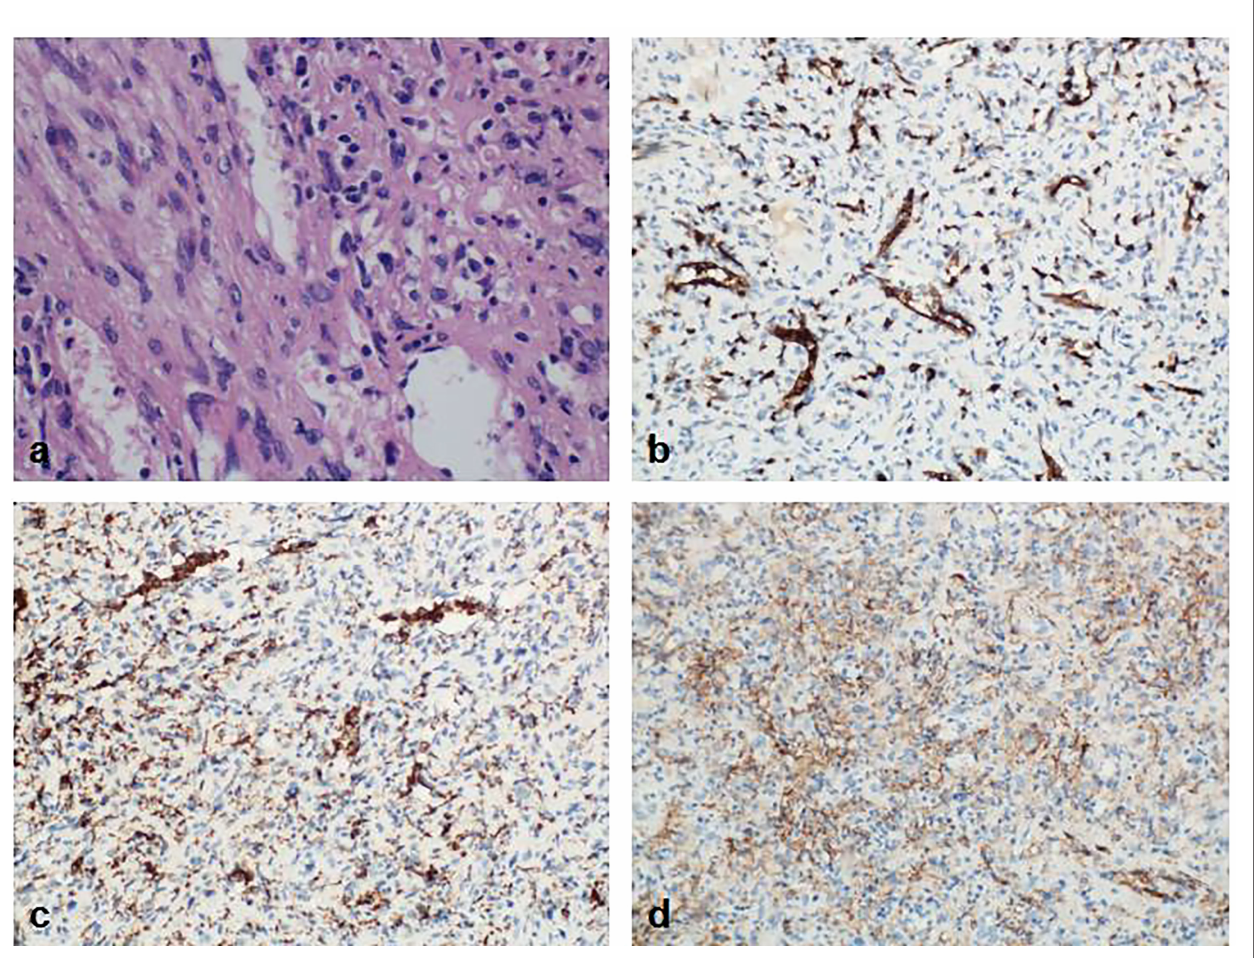
FIGURE 5 | Pathology result of the spleen. (A) The splenic tumor was in the shape of a round nodule, with a clear boundary with the surrounding normal spleen tissue. The tumor lost the structure of the red and white pulp of the normal spleen under the microscope. The cells were mainly composed of oval tissue-like cells and spindle-shaped muscle-like cells. Blood vessels were abundant; (B) Immunohistochemistry CD8(+); (C) Immunohistochemistry CD68(+); (D) Immunohistochemistry SMA (interstitial